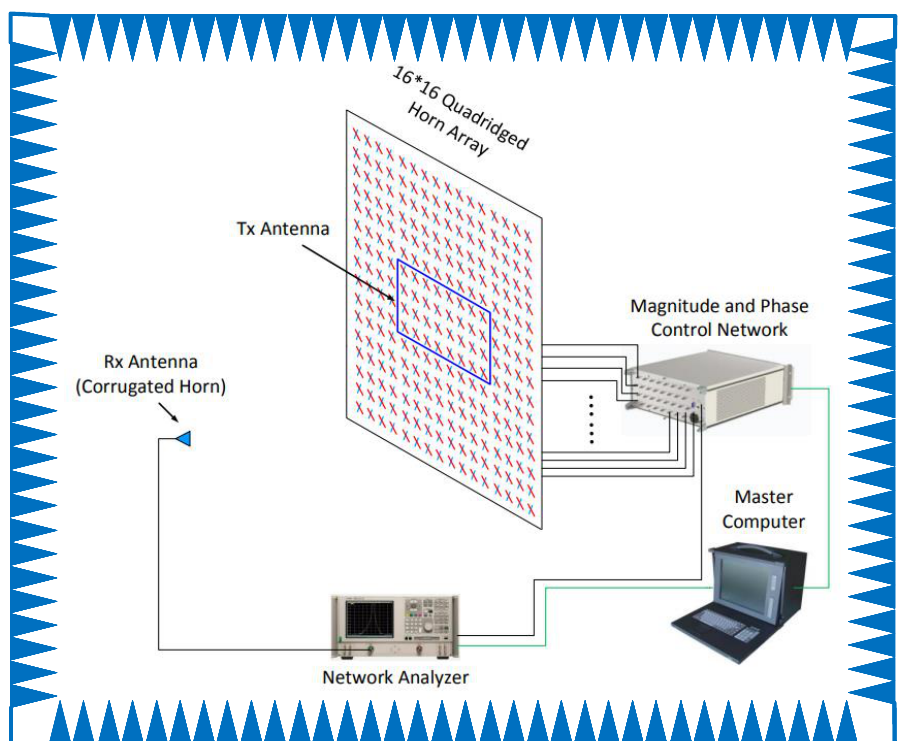
Figure 2. Schematic of the experimental